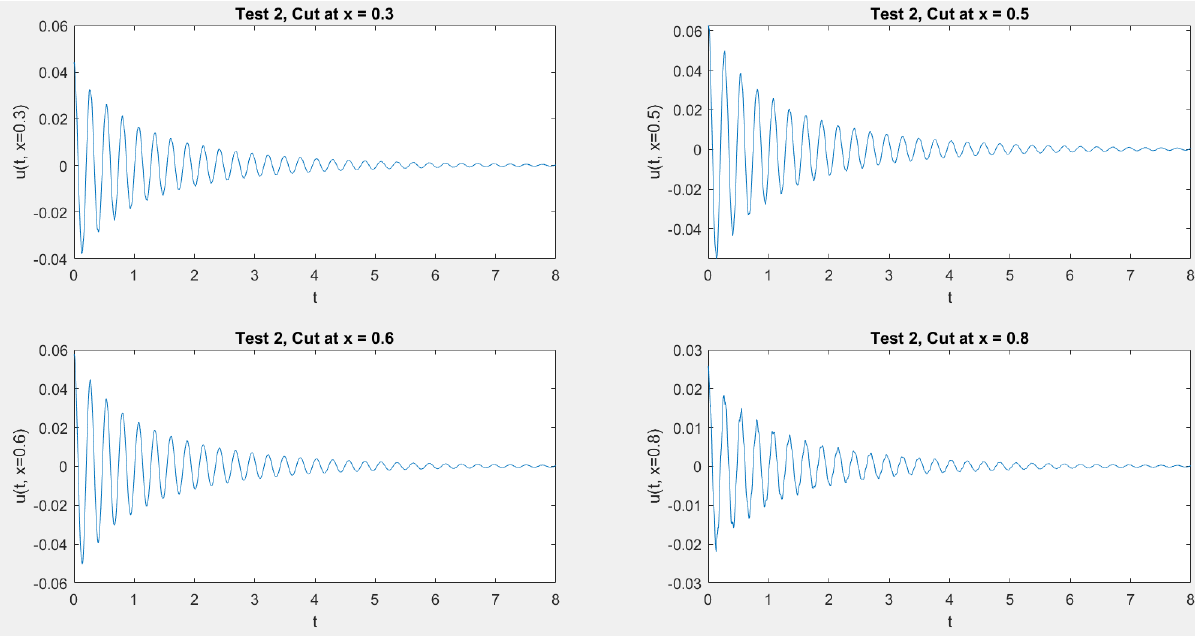
Figure 2. Test2: The solution u ( t ) at fixed values of x